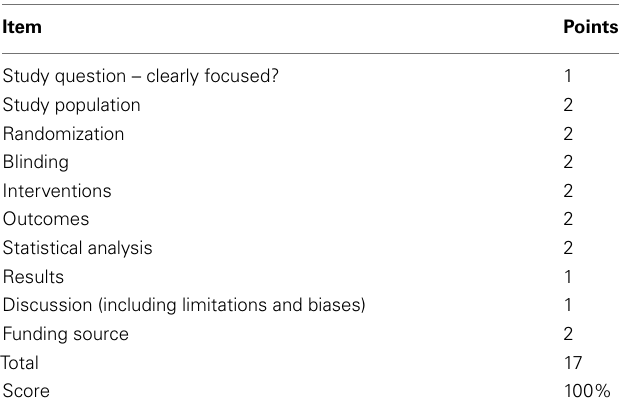
Table 2 |Table showing checklist for RCTs according to guidelines recommended byAHRQ.